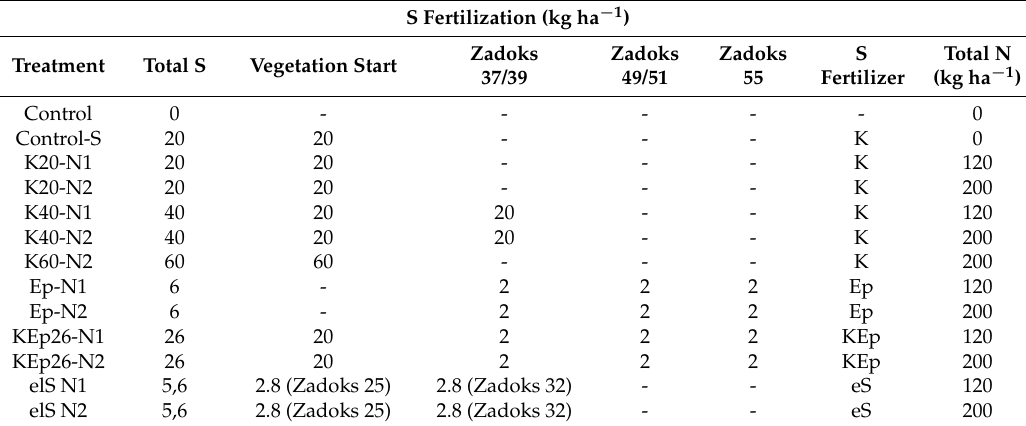
Table 3. Treatments in the S trial differing in amount, type (Kieserit: K, Epson salt: Ep, Kieserite + Epson salt: KEp, Elemental sulfur: elS) and temporal distribution of S fertilization and in amount of